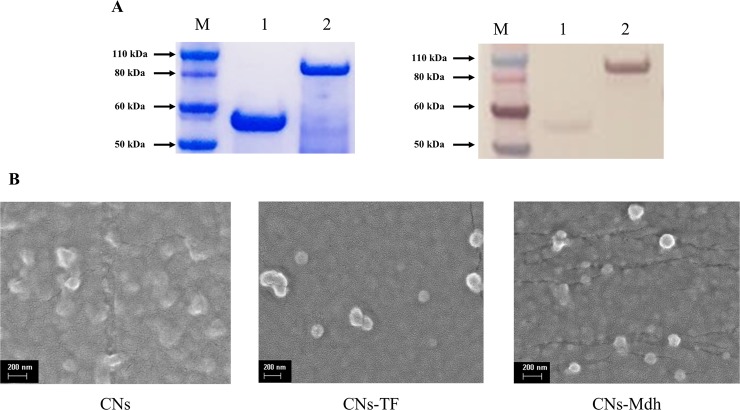
The confirmation of recombinant B. abortus proteins.SDS-PAGE and Western blotting (A). Lane M: Molecular size standard, 1: Control, TF (53 kDa), 2: Mdh (92.71 kDa). SEM photographs of prepared CNs (B).